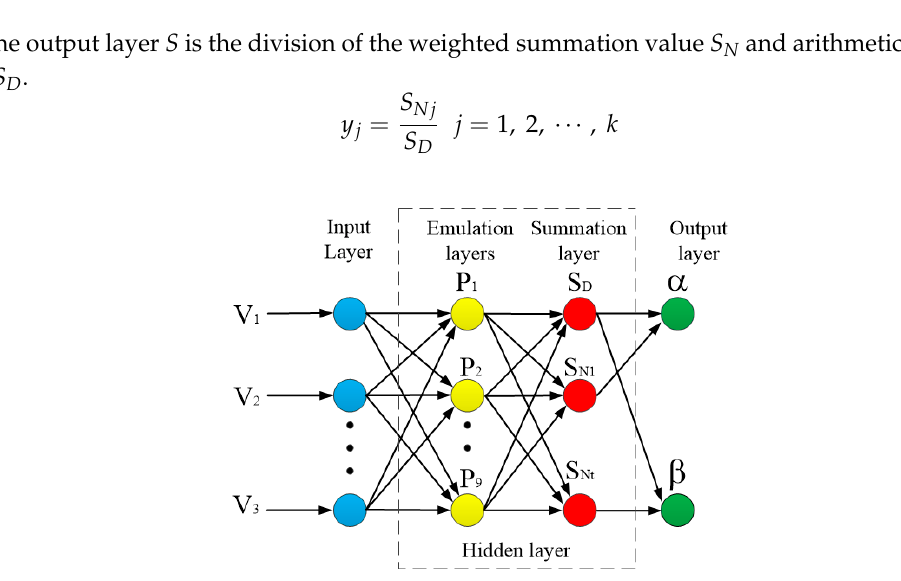
Figure 11. Generalized Regression Neural Network (GRNN) artificial neural network structure.